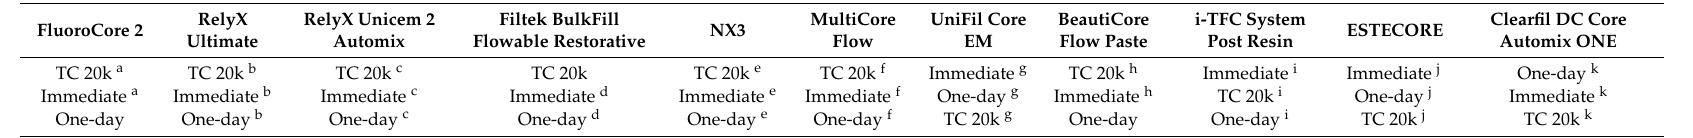
Table 11. Comparison of means (Tukey HSD Procedure) for pull-out force of each material with regard to time (superscript letters represent groups not significantly di ff erent, p > 0.05).